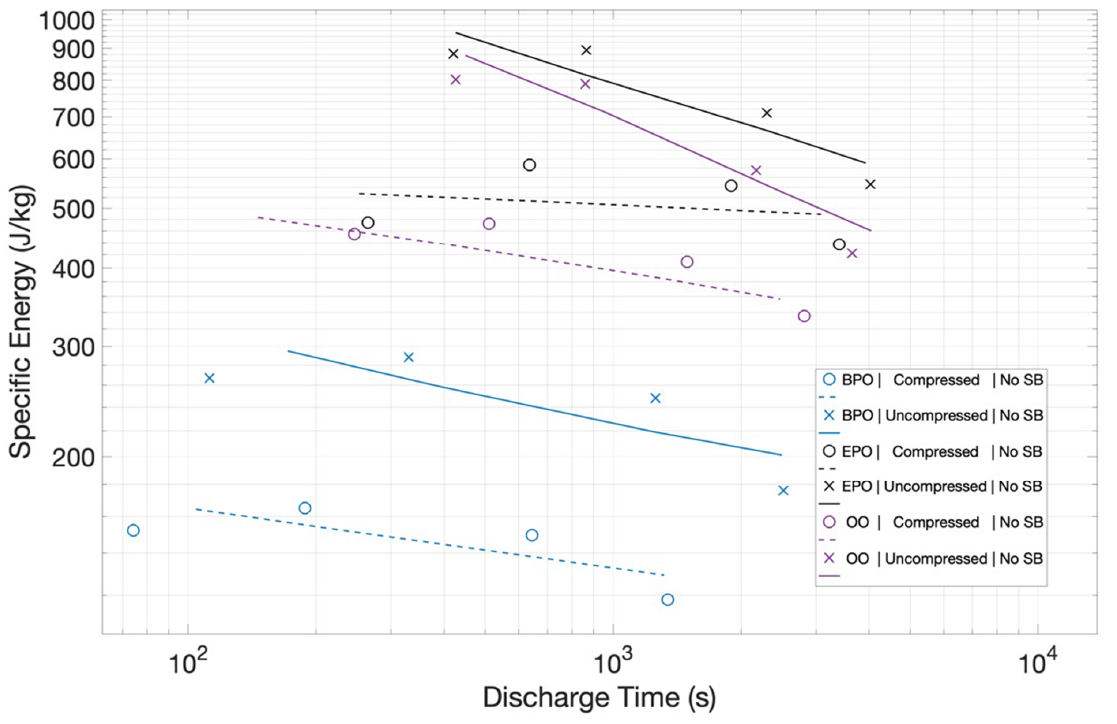
Figure 6. Summary of Specific Energy for Salt Bridge Free Capacitors. The energy density data for the six capacitors is shown. One previously unreported trend is apparent: The energy density is a strong function of electrode orientation. It is also clear that compressing/reducing the surface area of the graphitic electrode material reduces specific energy, and energy density decreases slowly with decreasing discharge time.